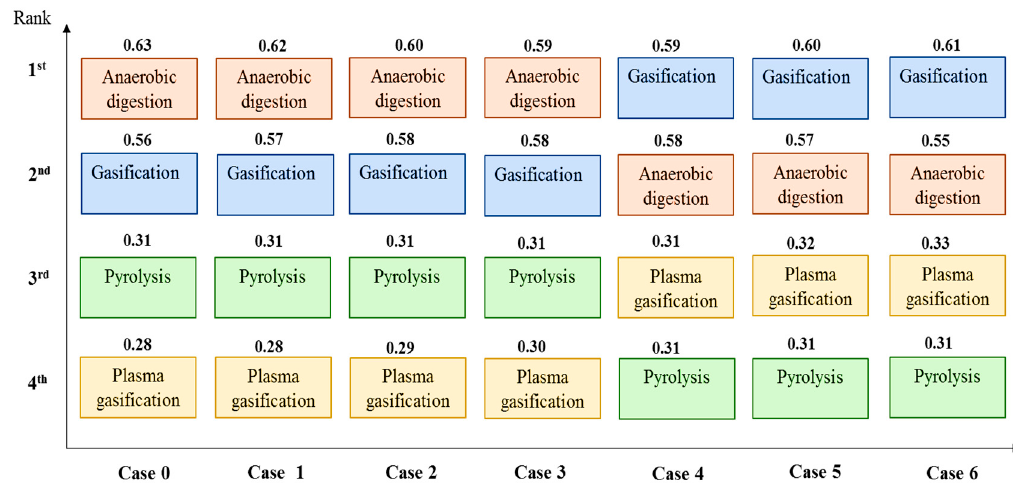
Figure 13. Sensitivity results of the criterion weight change on the ranking order for the WtE alter- natives. WtE